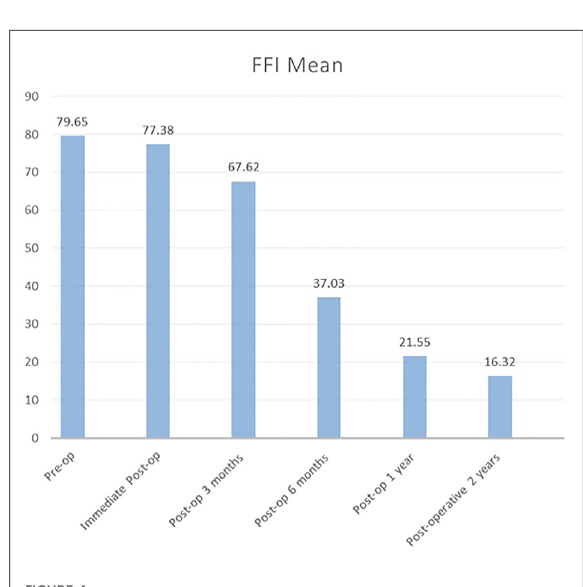
FIGURE 2 SF-36 mental component mean score for 2 years follow-up. SF-36, 36-Item Short-Form Health Survey.